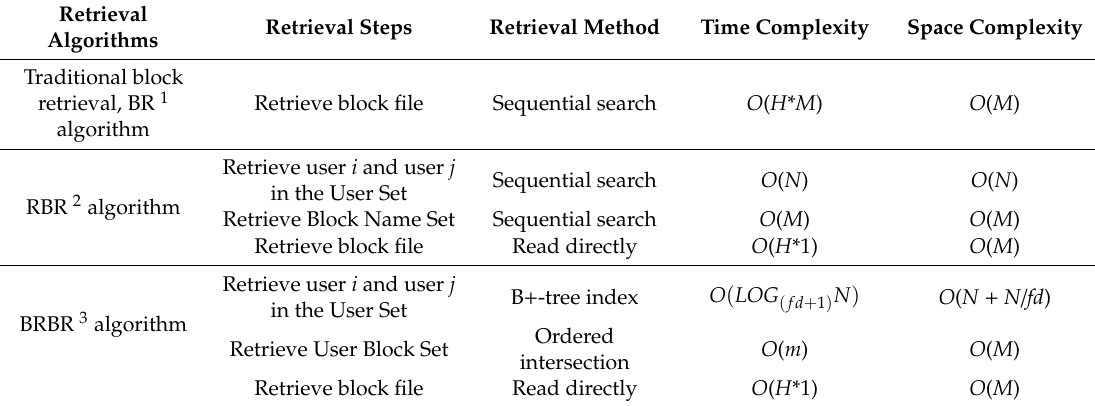
Table 2. Complexity analysis of three block retrieval